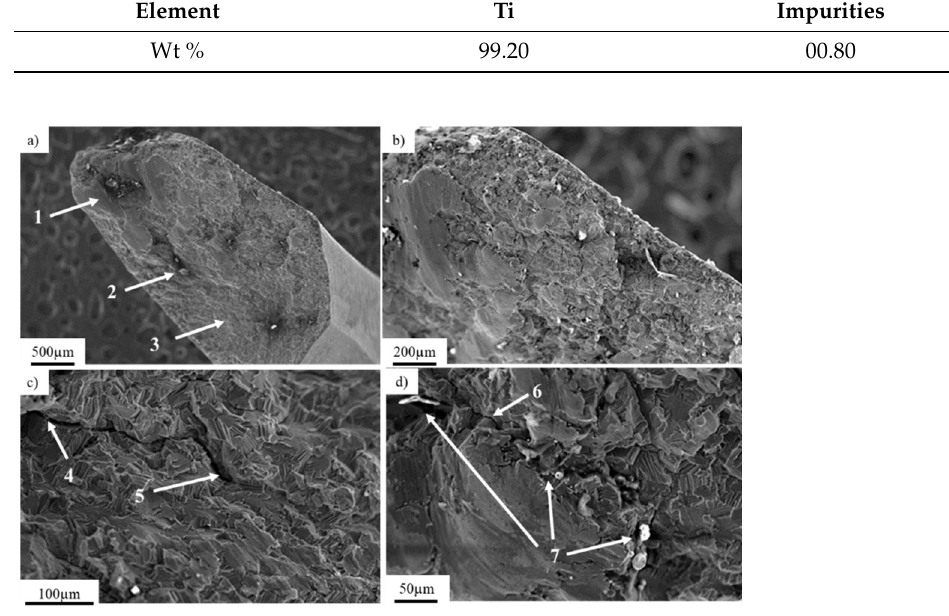
Table 1. Chemical composition of the titanium locking plate.